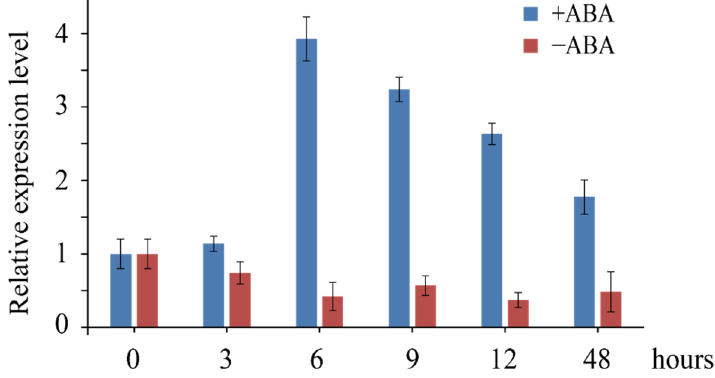
Figure 5. Expression patterns of LaCDKB1;2 during ABA treatment of L. kaempferi cultures. Cultures with (+ABA) or without (−ABA) ABA treatment were harvested at 0, 3, 6, 9, 12, or 48 h for qRT-PCR, with LaEF1A1 used as the internal control. Data are presented as the mean ± SE.